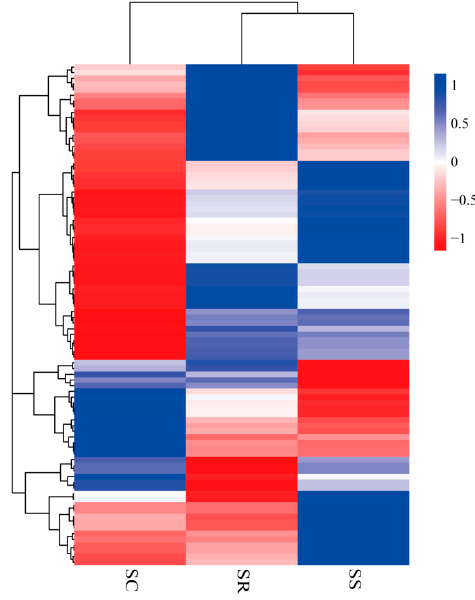
Figure 4. Heat map of the differentially expressed miRNAs in SC, SR, and SS groups.